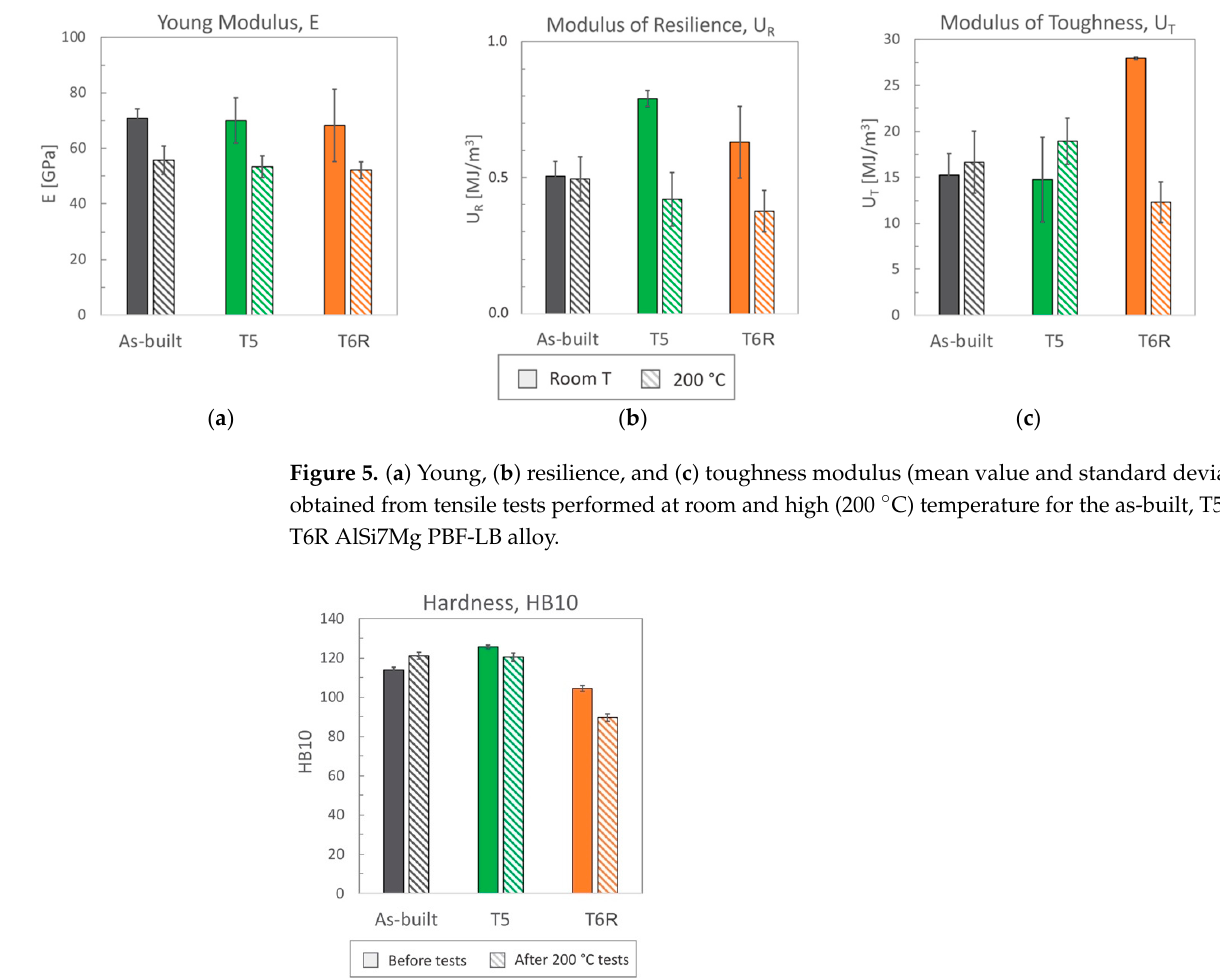
Figure 6. Hardness was evaluated on tensile samples after tests performed at room and high (200 °C) temperature for the as-built, T5, and T6R AlSi7Mg PBF-LB alloy (mean value and standard deviation). By focusing on room temperature tests, a significant difference in tensile behavior can be noticed according to the temper condition of the alloy. Differences are related